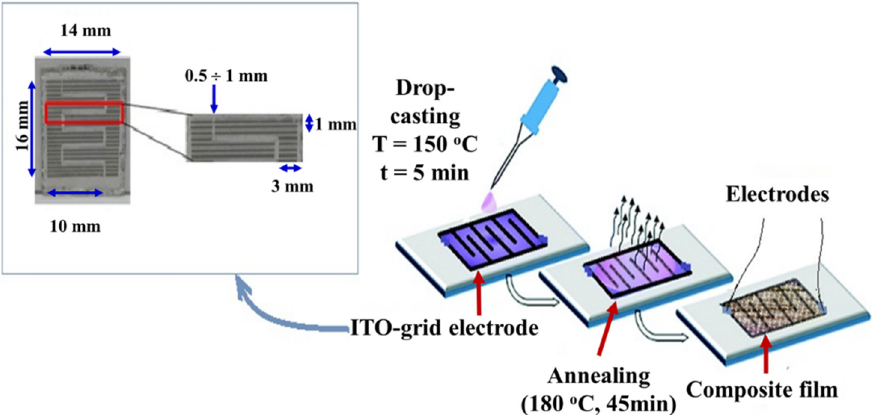
Figure 1. The schematic draw of the drop-casting technique for preparing resistance sensors.